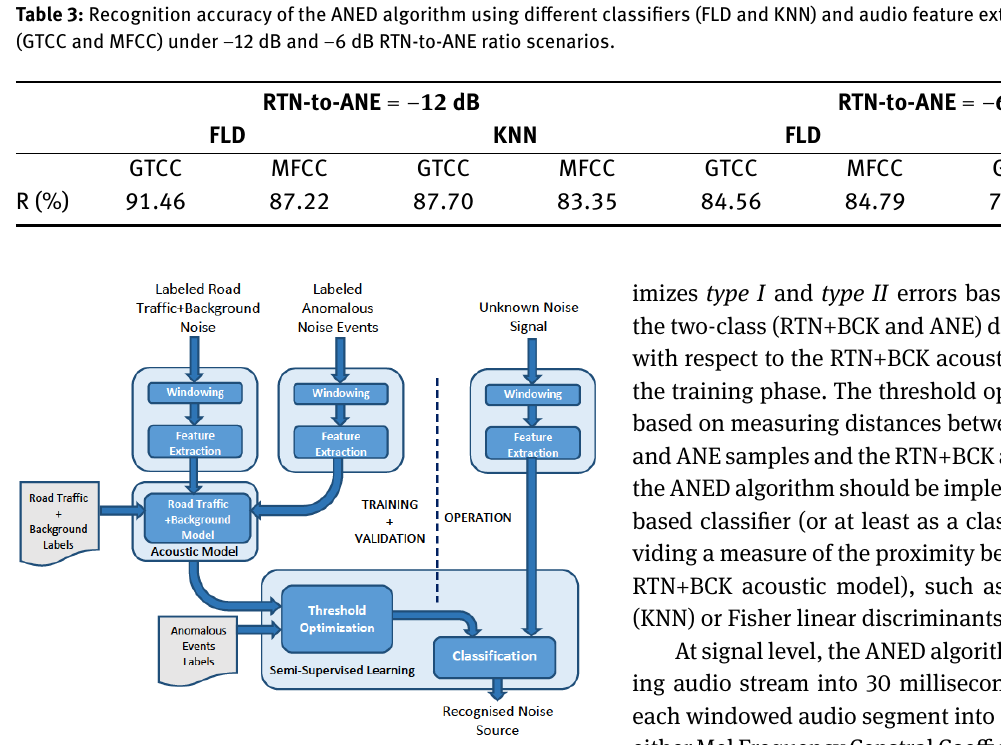
Figure 8: Block diagram of the anomalous noise event detection